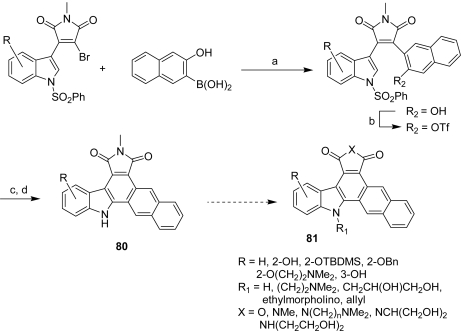
(a) Pd(OAc)2, K2CO3, dioxane/H2O, 100 °C. (b) Tf2O, Et3N, CH2Cl2. (c) Pd(OAc)2, PPh3, Bu4NCl, NaOAc, dioxane, 100 °C. (d) Bu4NF, THF, reflux.